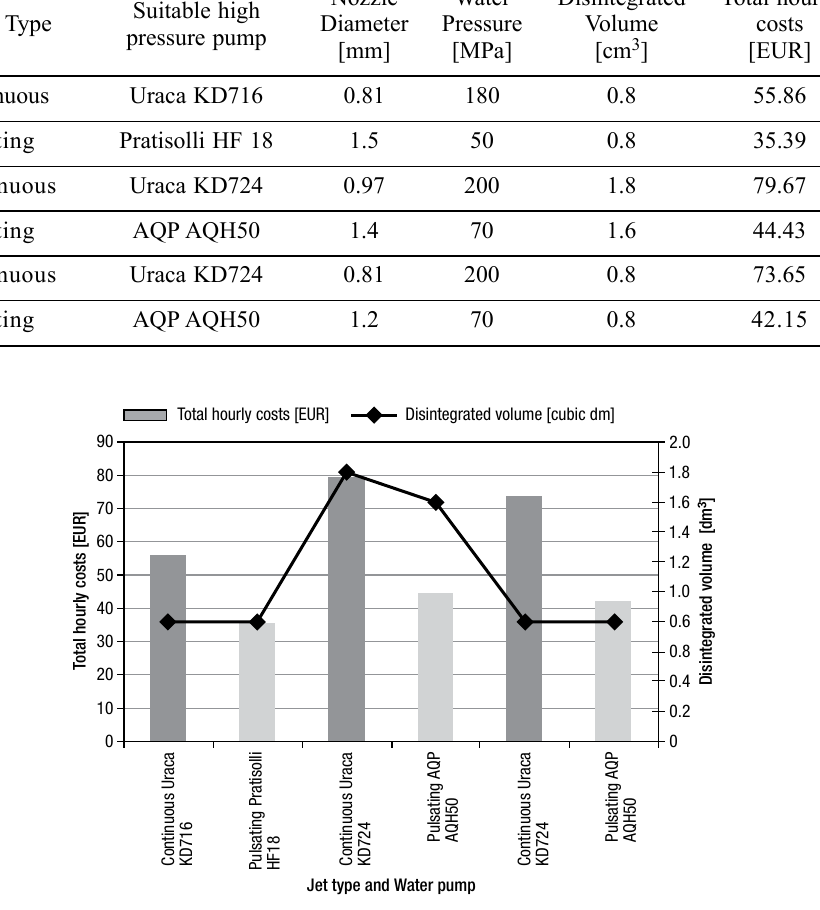
Fig. 3. Total hourly cost for continuous and pulsating water